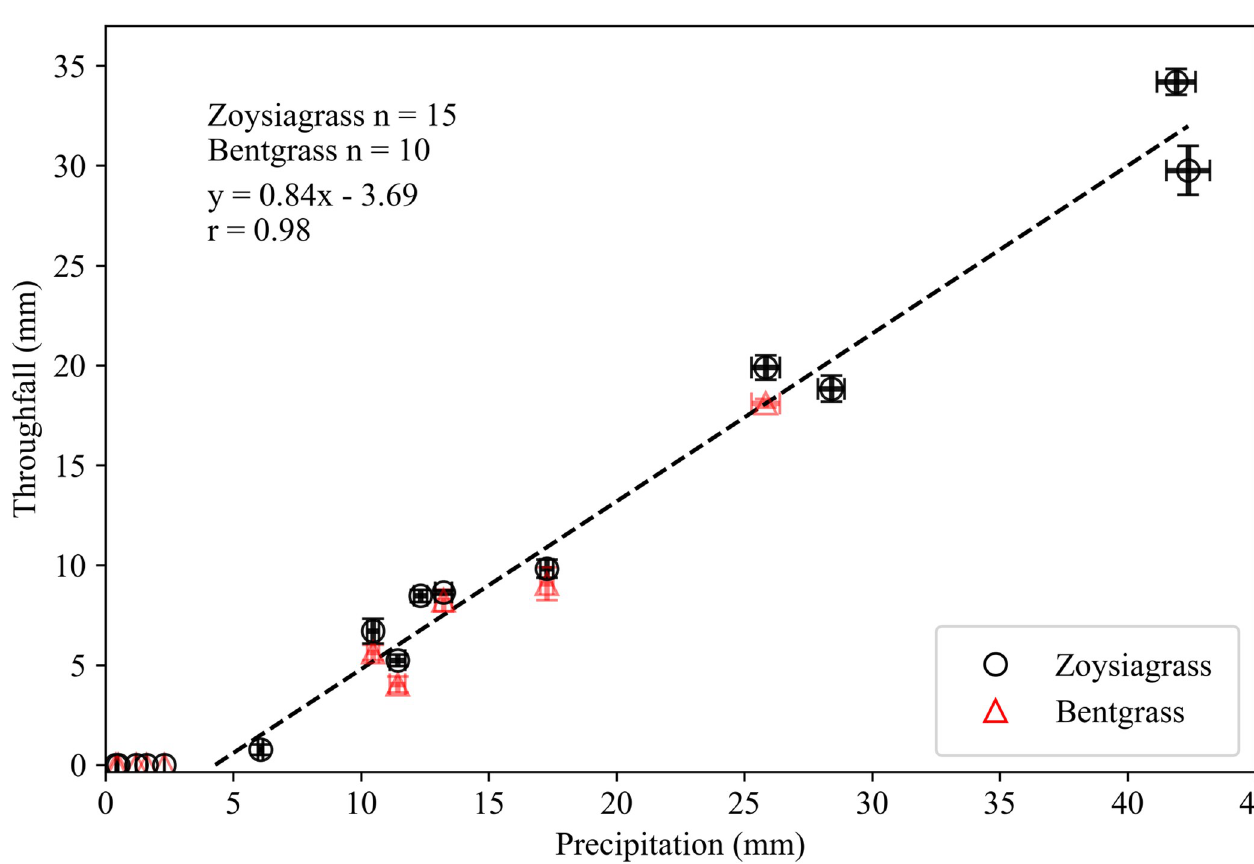
Fig 2. Relationship between precipitation and throughfall amount of patches of zoysiagrass and creeping bentgrass for all 15 natural storms. The x - intercept of 4.4 mm (95% CI [3.6, 5.3]) represents the minimum canopy interception before throughfall begins. The linear fitting exercise was done only using storm events that had throughfall > 0 mm. Error bars represent the standard deviation of throughfall and precipitation. For some markers error bars are masked by the marker size.